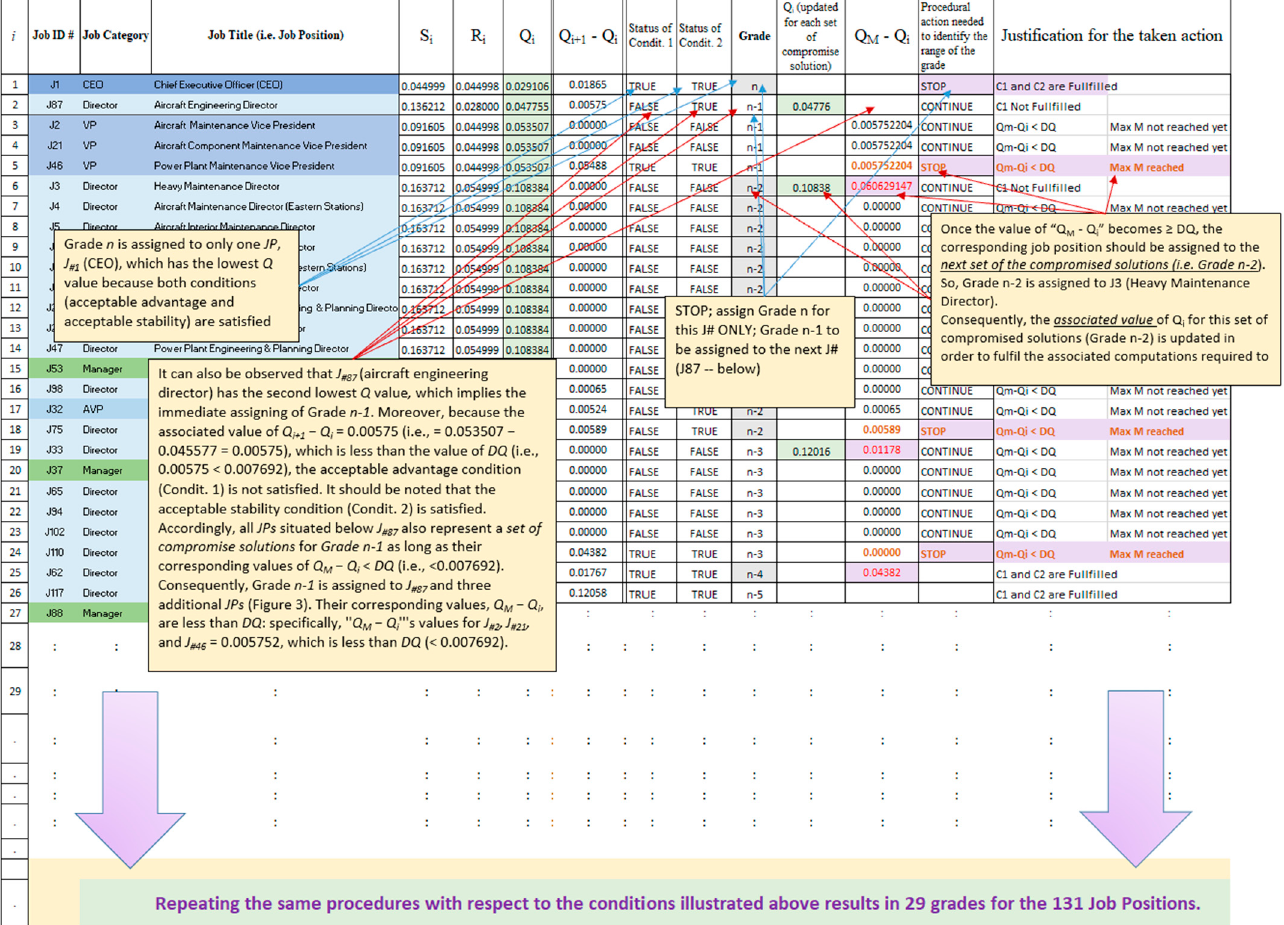
Figure 3. Grade identification using the VIKOR algorithm.